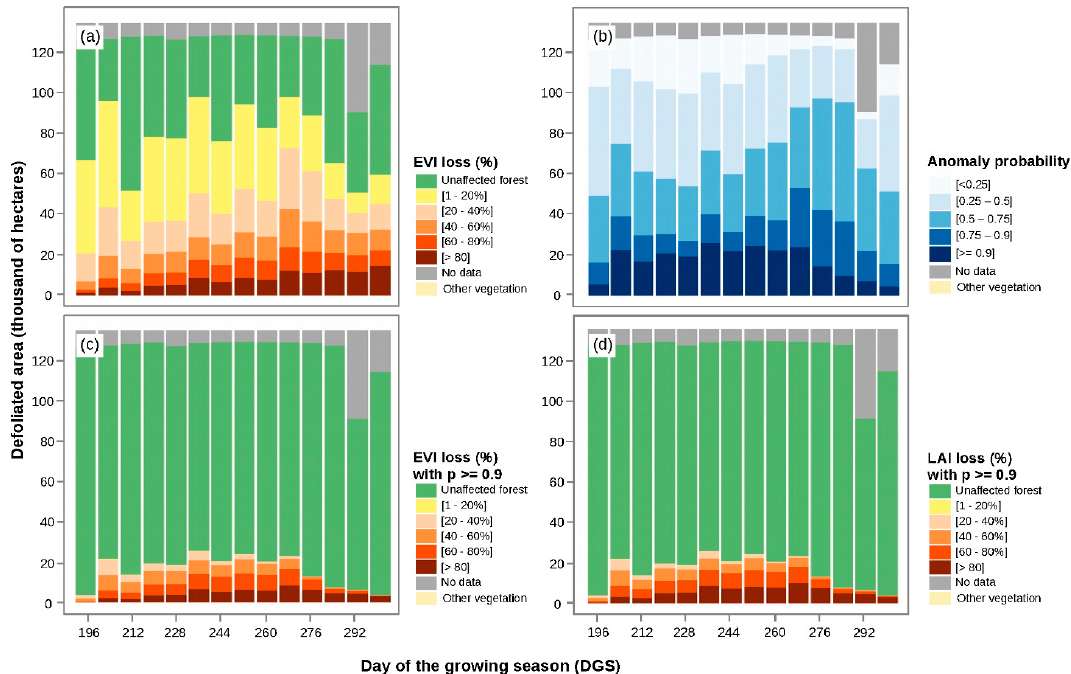
Figure 6. Surface of N. pumilio forest affected by different levels of O. amphimone defoliation during the summer 2015–2016 (DGS 196: 9 January 2016 to DGS 292: 15 April 2016). ( a ) EVI loss (%) before the anomaly probability band is used to mask out “non-significant” values; ( b ) anomaly probability values (in the present study only EVI loss (%) values with probabilities ≥ 0.9 of being “true” defoliation were considered); ( c ) EVI loss (%) with anomaly probability ≥ 0.9; ( d ) LAI loss with anomaly probability ≥